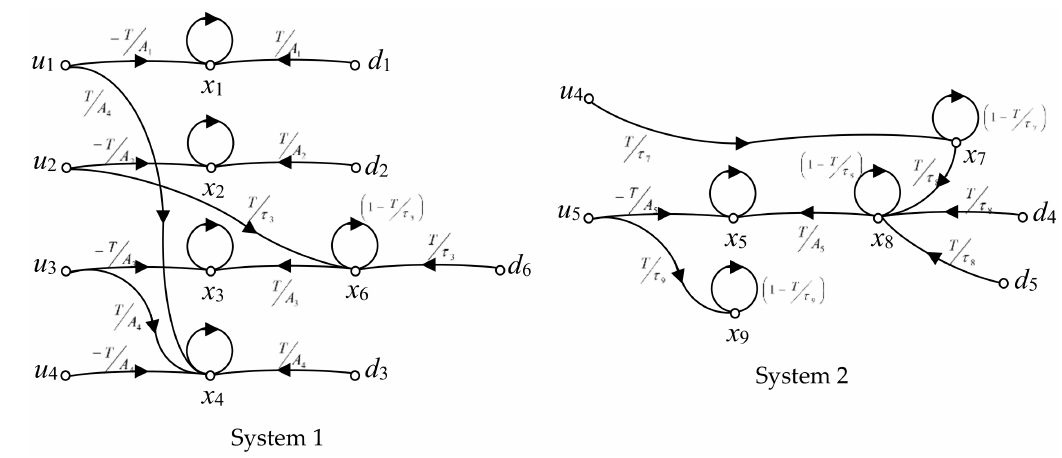
Figure 4. System